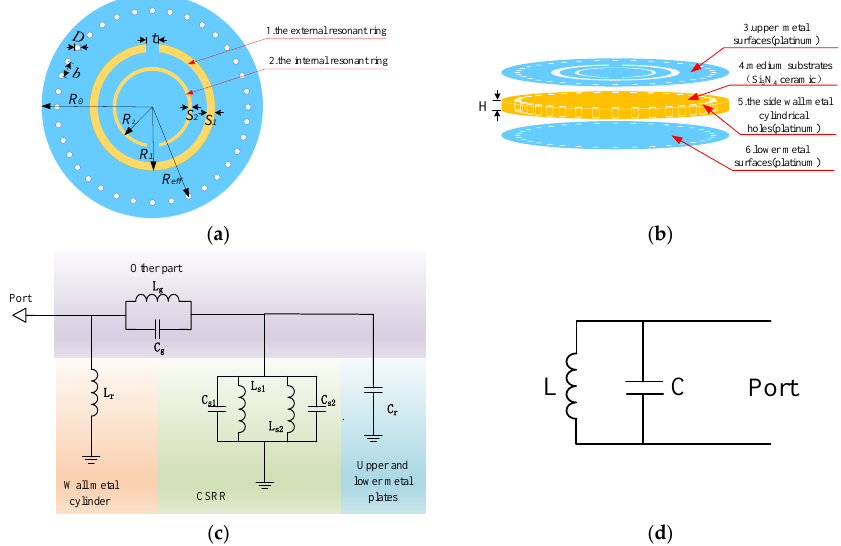
Figure 2. ( a ) Sketch diagram of the front sensor ( b ) Sketch diagram of the side sensor ( c ) Equiva- lent circuit diagram of the sensor ( d ) Simplified equivalent circuit diagram of the sensor.